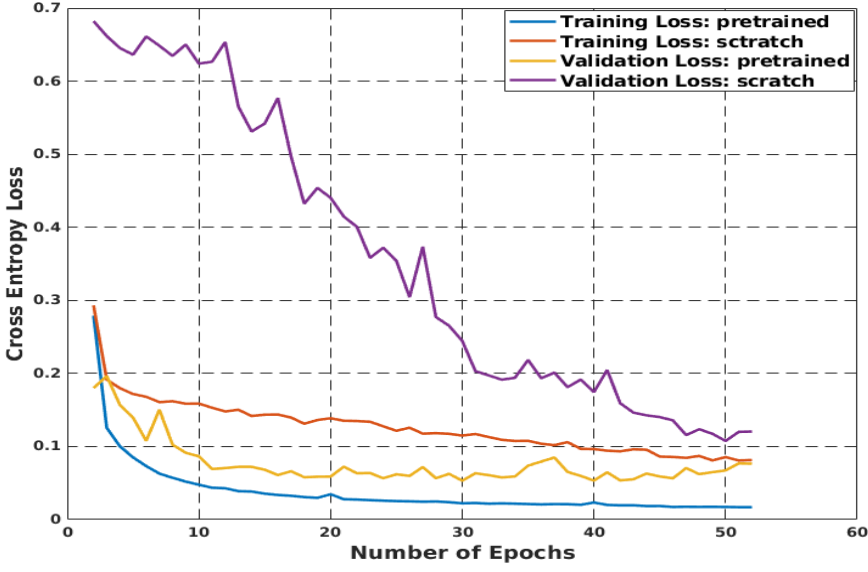
Figure 5. Comparison between model from scratch and model initialized with pre-trained classifica- tion